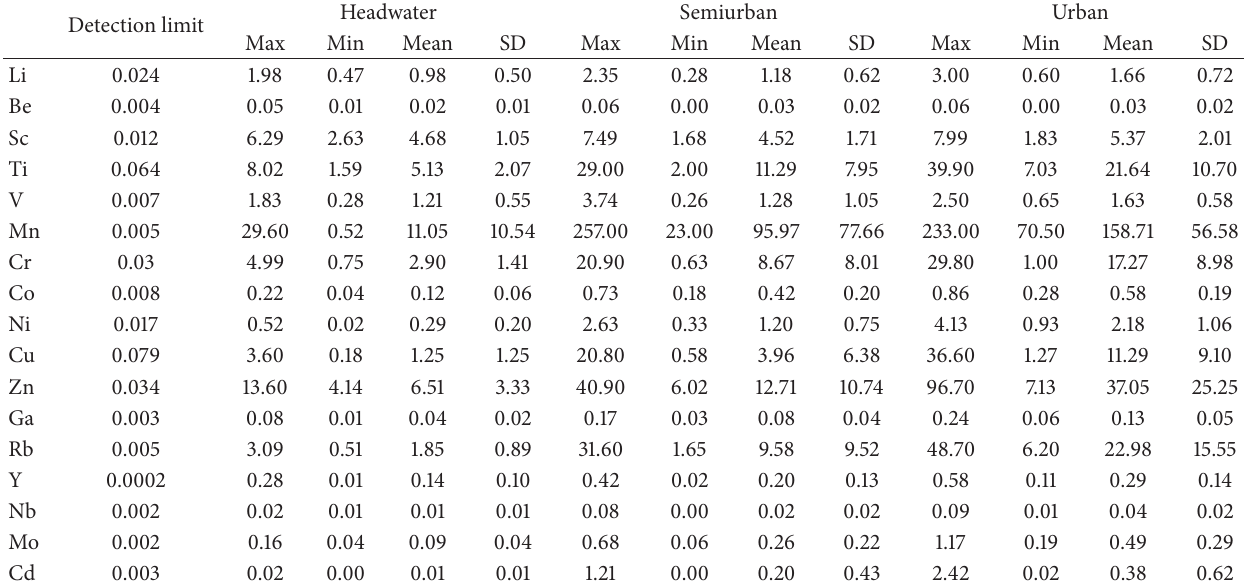
Table 3: Variation of average concentration (expressed in 𝜇 g/L) of the elements in three sections of the Bagmati River basin within the Kathmandu